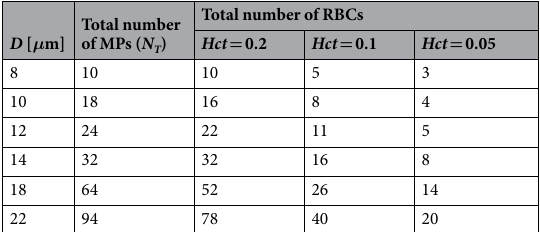
Table 1. Total number of MPs and